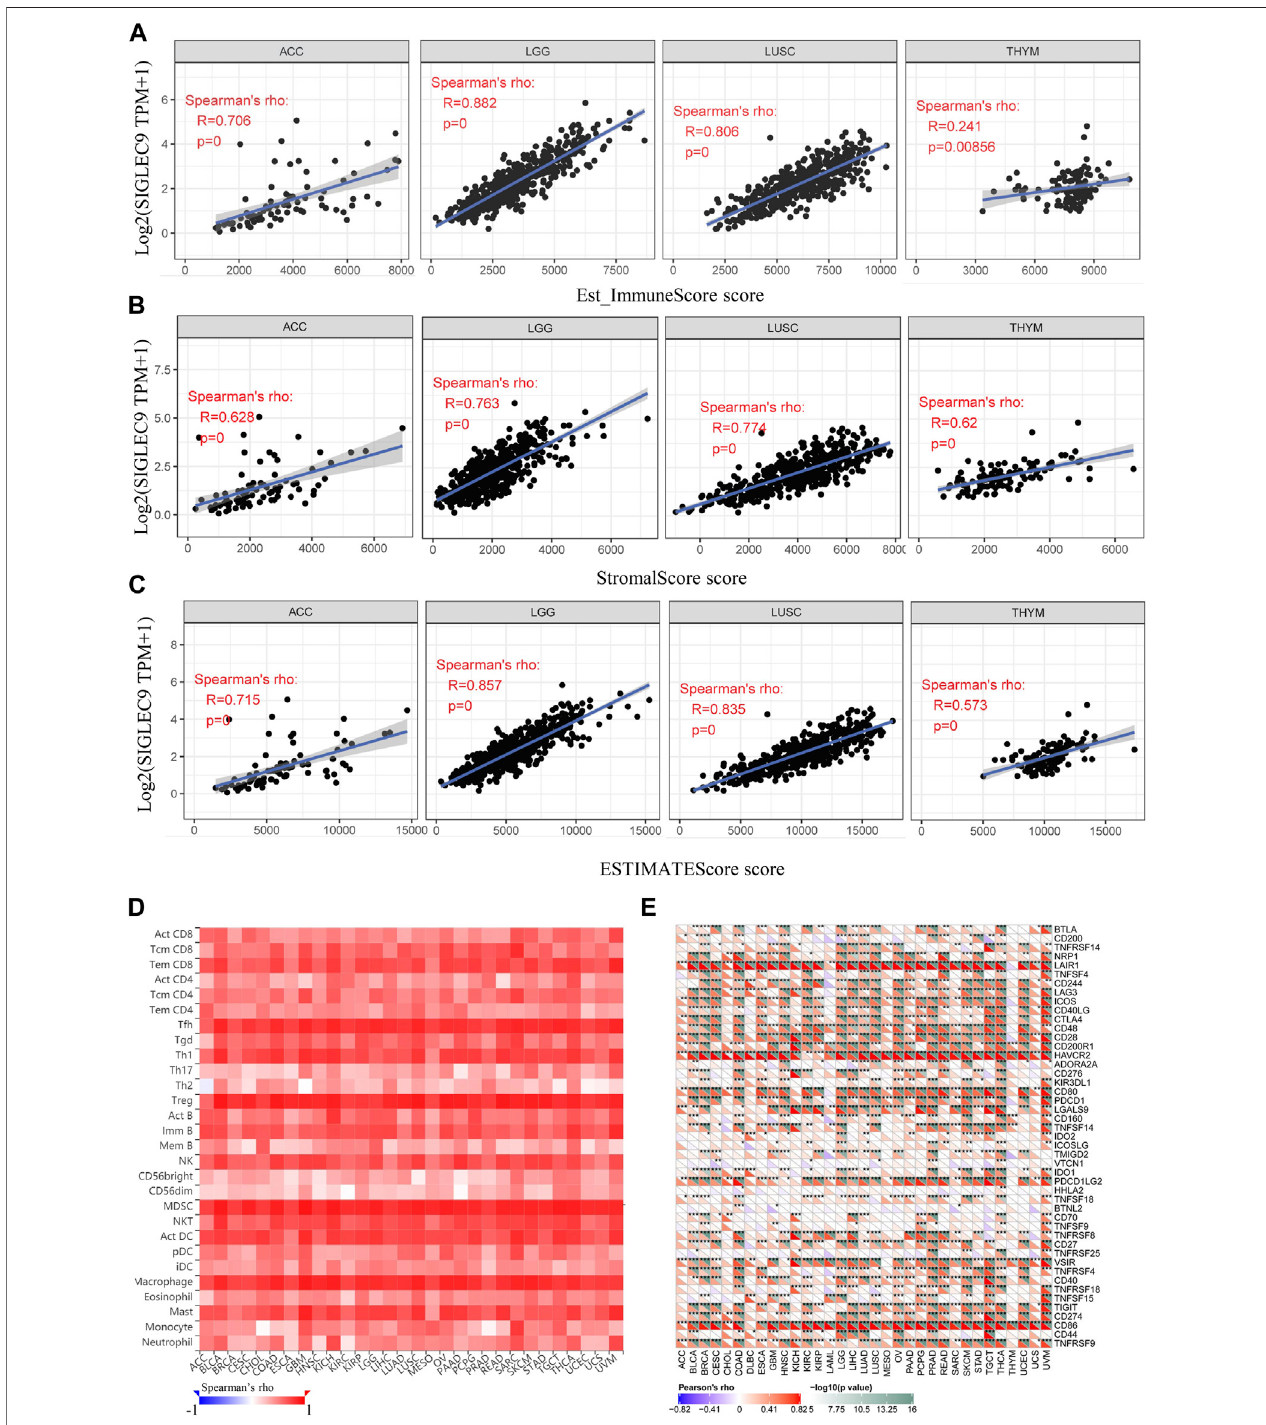
FIGURE6| TherelationshipbetweenSiglec-9mRNAexpressionandimmunescore,stromalscore,ESTIMATEscore,speci fi cimmunecellin fi ltration,andimmune checkpoints. (A) Correlation between Siglec-9 mRNA expression and Immune Score in ACC, LGG, LUSC, and THYM. (B) Correlation between Siglec-9 mRNA expression and Stromal Score in ACC, LGG, LUSC, and THYM. (C) Correlation between Siglec-9 mRNA expression and ESTIMATE score in ACC, LGG, LUSC, and THYM. (D) Correlation between immune cells and Siglec-9 mRNA expression according to TISIDB. (E) Correlation between the immune checkpoint and Siglec-9 mRNA expression. (A – D) Spearman correlation; (E) Pearson ’ s correlation ( p < 0.05 was considered signi fi cant).